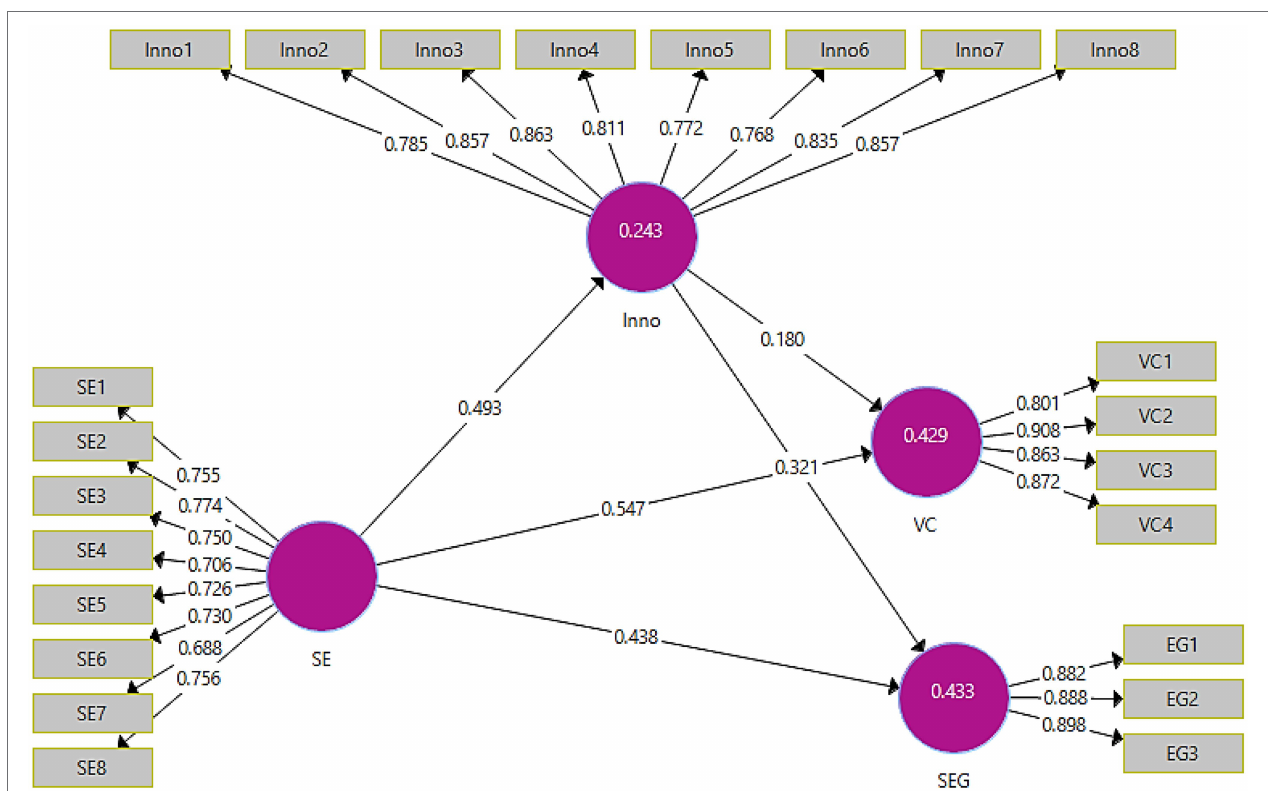
FIGURE 2 | Output of measurement model. SE, social entrepreneurship; inno, innovation; SEG, sustainable economic growth; VC, value creation.